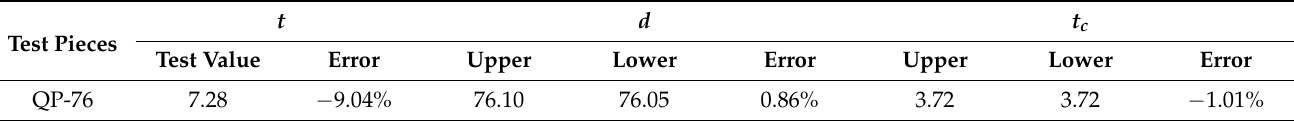
Table 3. Measurement results of specimen size (mm).